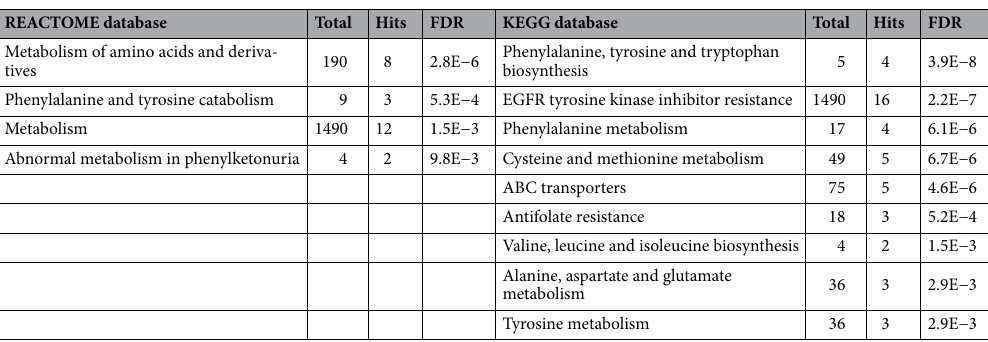
Table 2. Integrative pathway enrichment analysis of the dysregulated proteins and metabolites by simulated diabetes.